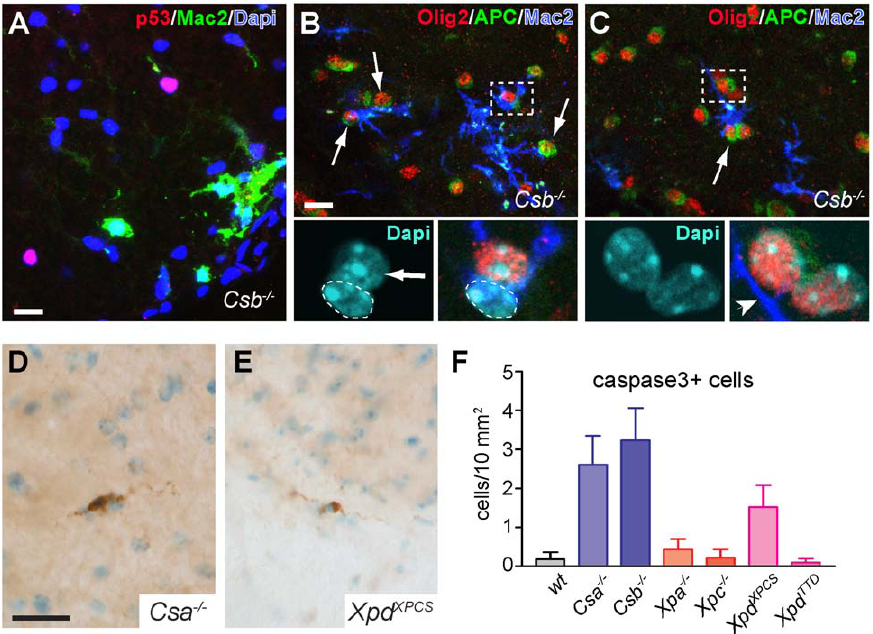
Figure 3. Mac2-positive microglia cells enwrap oligodendrocytes in CS mice. A) Double-labeling confocal images of p53 and Mac2 in DAPI- counterstained spinal cord section of Csb 2 / 2 mouse showing that Mac2-immunoreactive microglia cells do not colocalize with p53-labeled cells. B, C) Triple-labeling confocal images of Mac2 and the oligodendrocyte markers Olig2 and APC showing Mac2-immunoreactive microglia cells that closely embrace mature oligodendrocytes labeled by Olig2 and APC. The dashed line in (B) outlines the nucleus of the Mac2-positive microglia cell. Arrows in B and C indicate oligodendrocytes contacted by Mac2-positive microglia cells. D–F) Photomicrographs and bar graph of active caspase 3 immunoreactive cells in spinal cord of 25 week old Csa 2 / 2 , Csb 2 / 2 and Xpd XPCS mice. Values are means 6 SE of 3 or 4 mice, while value per mouse is based on analysis of 10 cervical spinal cord sections. Scale bars: 20 m m.